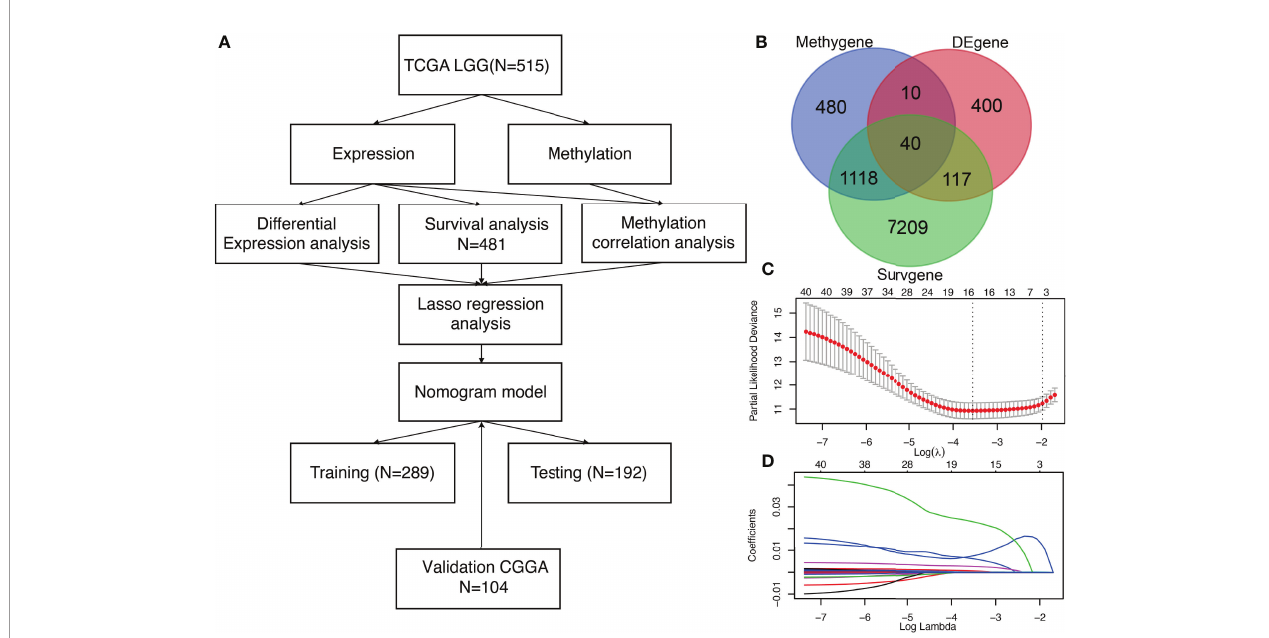
FIGURE 1 | Identi fi cation of three signi fi cant prognostic genes in LGG and LASSO results (A) Technical roadmap for the whole study. (B) Venn diagram of 40 OCGs. (C) Partial likelihood deviance for LASSO regression. (D) LASSO regression analysis of 40 genes in LGG.